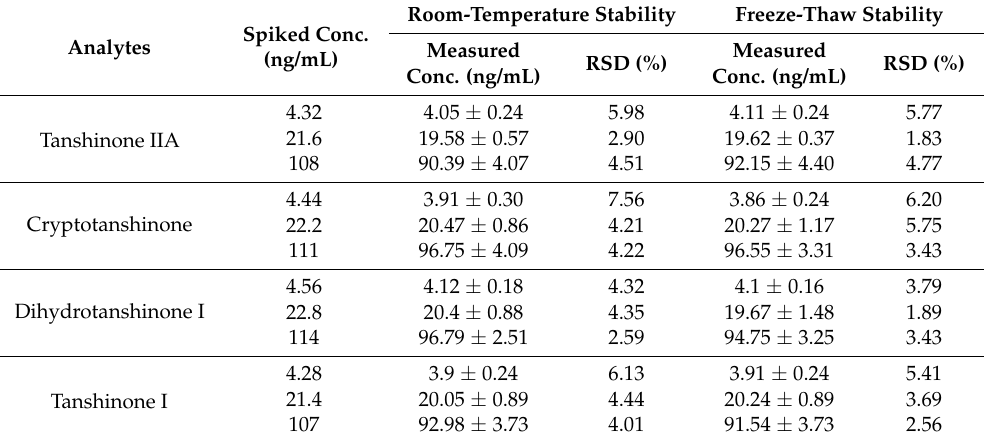
Table 5. Room-temperature stability and triple freeze-thaw stability of four tanshinones in QC samples at three concentration levels ( n = 6).